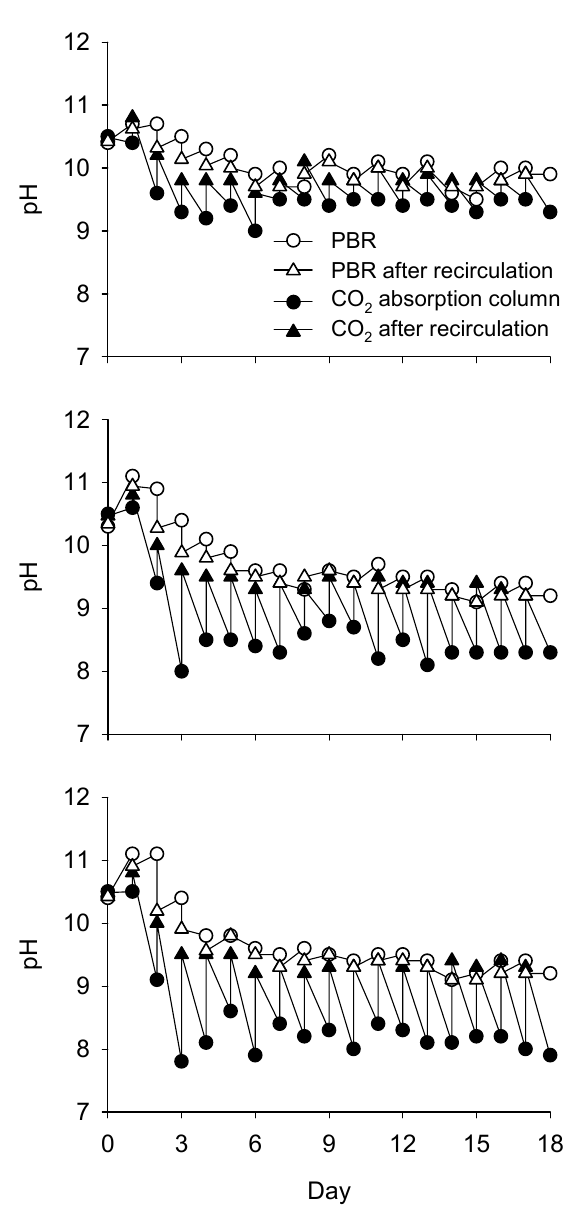
Figure 2. Time course of pH of each reactor (photobioreactors: PBR; and CO 2 absorption columns). There are two points in a day, representing pH change due to the circulation of medium between PBR and absorption column.